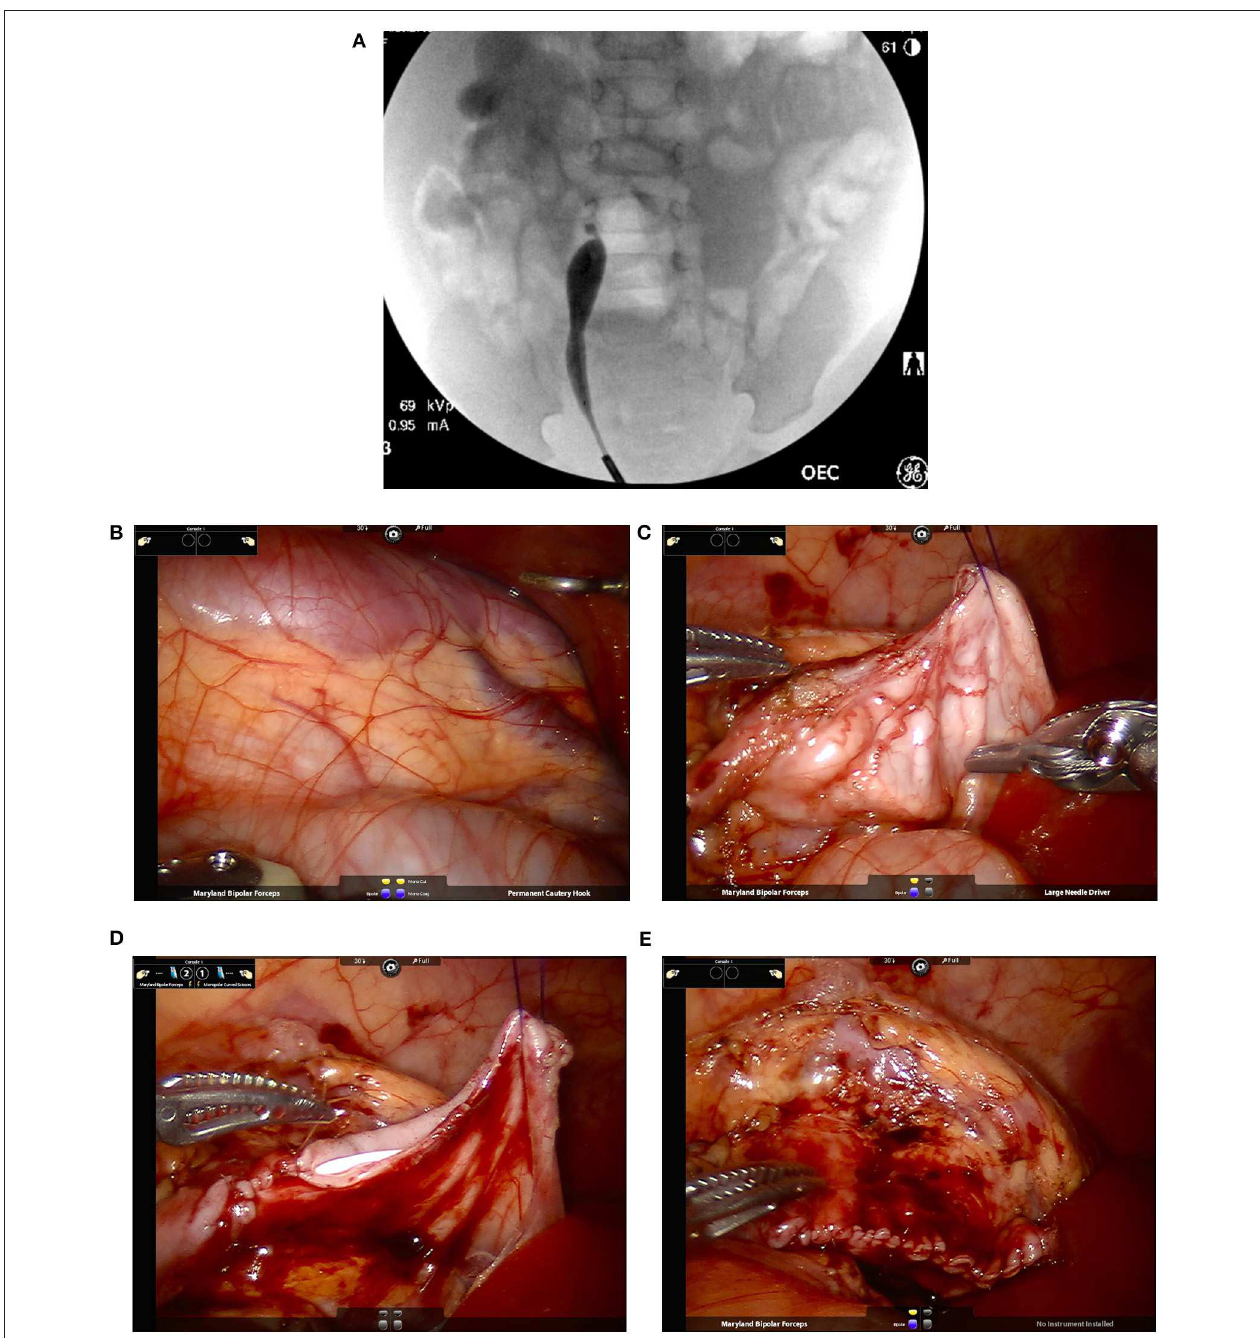
FIGURE 5 | Intra-operative pictures and findings of robotic-assisted laparoscopic pyeloplasty in an infant. (A) A retrograde pyelogram performed at the beginning of the case allows for localization of the stricture as well as assessment of its length. This allows for easier planning of reconstructive technique (e.g., dismembered pyeloplasty vs. the need of a flap for longer narrow segments). In addition, it allows for detection of possible distal strictures. A stent is placed at the end prior to the robotic portion of the case. (B) Identification of the right kidney with a dilated renal pelvis visible underneath the peritoneum. (C) Once the renal pelvis and proximal ureter are dissection, placement of trans-abdominal hitch stich facilitate exposure of the operative field while avoiding the potential use of excessive retraction force by robotic instruments. (D) Suturing over the ureteral stent that was placed in a retrograde fashion at time of retrograde pyelogram. (E) Complete repair. In the case used for the images, a fair amount of redundant renal pelvis was